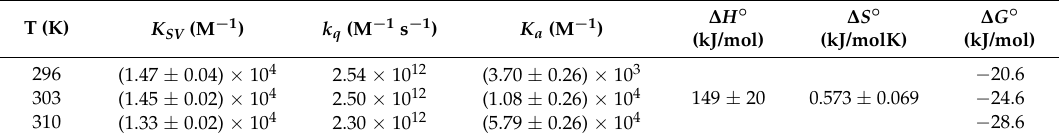
Table 1. Stern-Volmer quenching constant ( K SV ), bimolecular quenching rate constant ( k q ), modified Stern-Volmer binding constant ( K a ) and thermodynamic parameters ( ∆ H ◦ , ∆ S ◦ , and ∆ G ◦ ) for HSA: RPF101 at 296, 303, and 310 K a